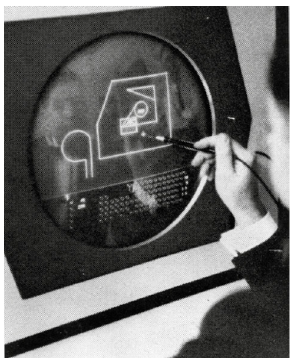
Figure 2. Written on sketchpad in 1963.